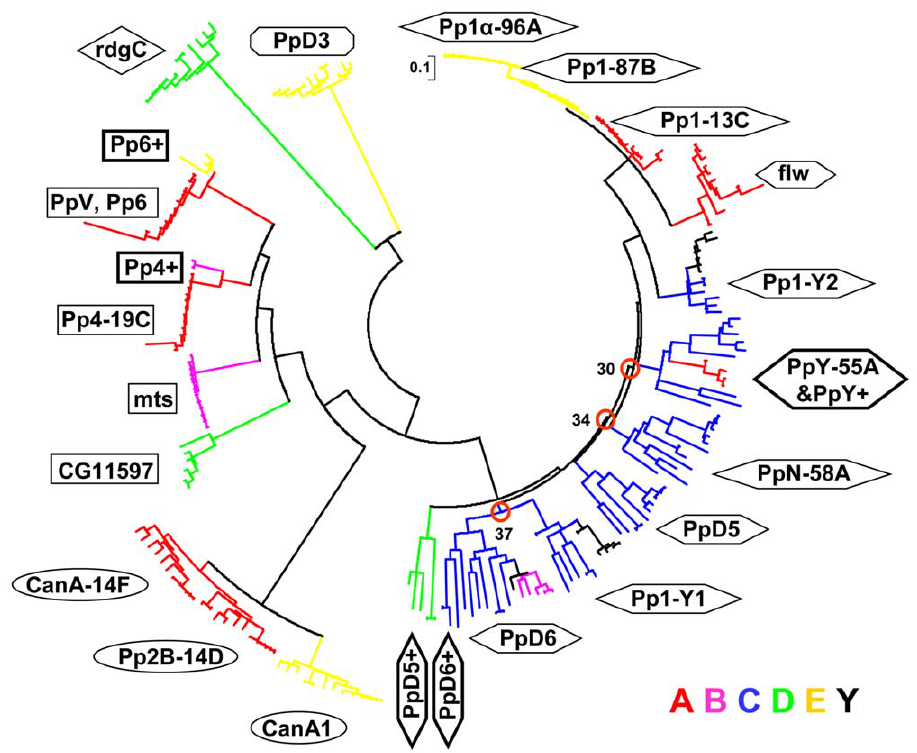
Figure 3. Phylogeny of PPP catalytic subunits in Drosophilidae . The phylogenetic analysis of 227 Drosophila PPP catalytic subunits is presented as in Figure 2 . The color of the branches indicates the chromosomal localization of the corresponding genes, the color code of the Muller elements is given in the lower right corner. The names of the 5 novel PPP enzymes that were identified in the present study are labeled by a + suffix and are surrounded by a heavy border. The scale indicates 0.1 amino acid substitutions per site in the primary structure.